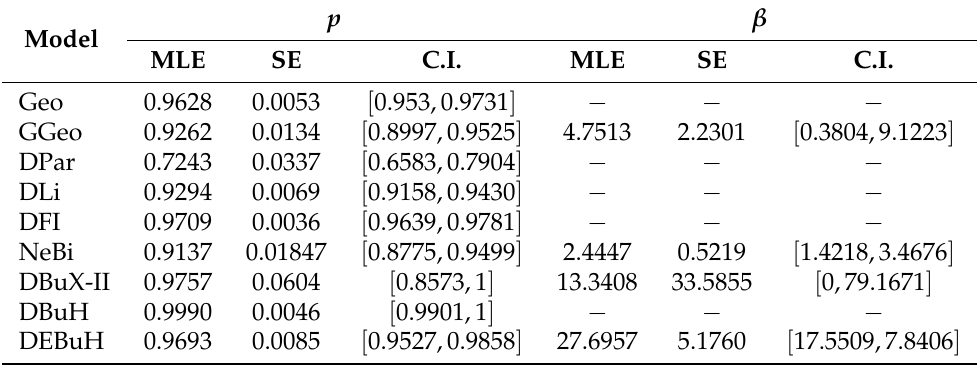
Table 9. The MLEs, SE, and C.I. of the DEBuH model and other discrete models for data set II.